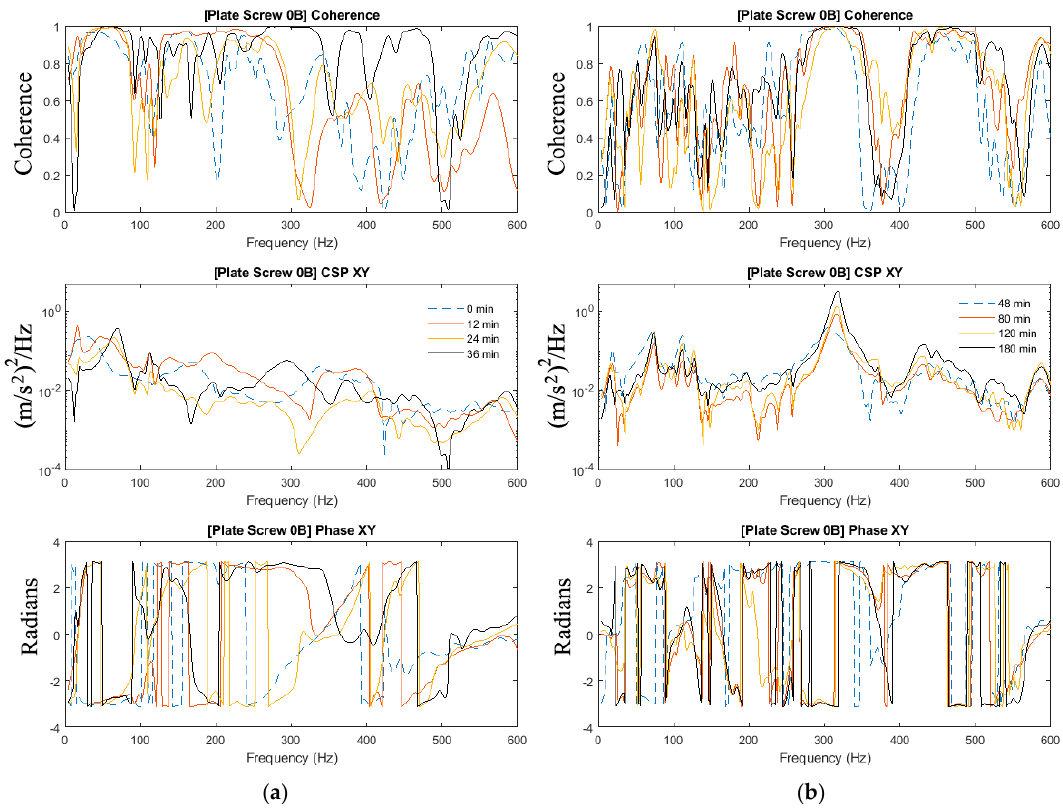
Figure 5. Coherence, cross-spectra and phase functions of Test #0B experimental investigations; ( a ) from 0 to 36 min and ( b ) from 48 to 180